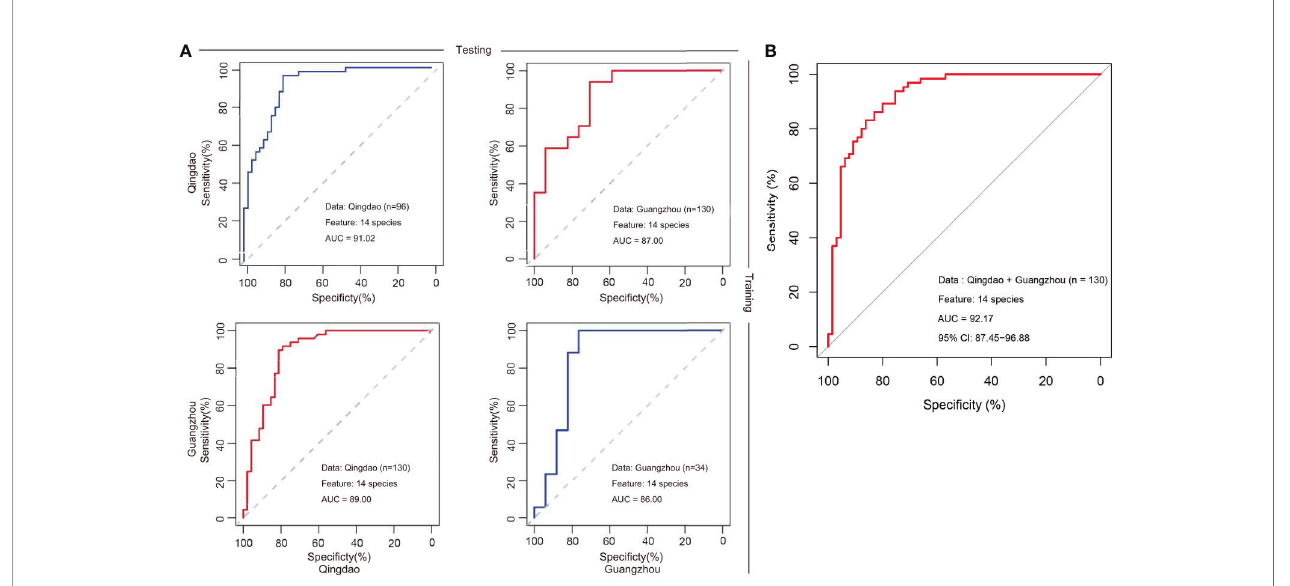
FIGURE 6 | Cross-applications of caries diagnosis models based on microbiomes from Qingdao and Guangzhou cohorts. We constructed caries diagnosis models in the saliva microbiota from either Qingdao or Guangzhou population. Using either Qingdao or Guangzhou microbiota, status (heathy and caries) can be distinguished with a high prediction accuracy (AUC) in the 10-fold CV for random forests model. (A) The prediction performance of models in the Qingdao (AUC=91.02%, Guangzhou (AUC=86.16%) and model application from one city to another. A classi fi cation model trained in Qingdao data and tested in Guangzhou Data resulting in a AUC=87.00%; A classi fi cation model trained in Guangzhou data and tested in Qingdao Data resulting in a AUC=89.00%. (B) The predictive performance using data from two cities